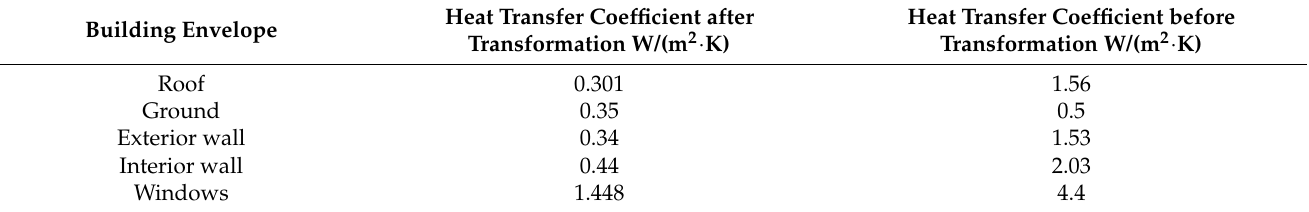
Table 1. The thermal resistance of the envelope structure before and after the transformation.